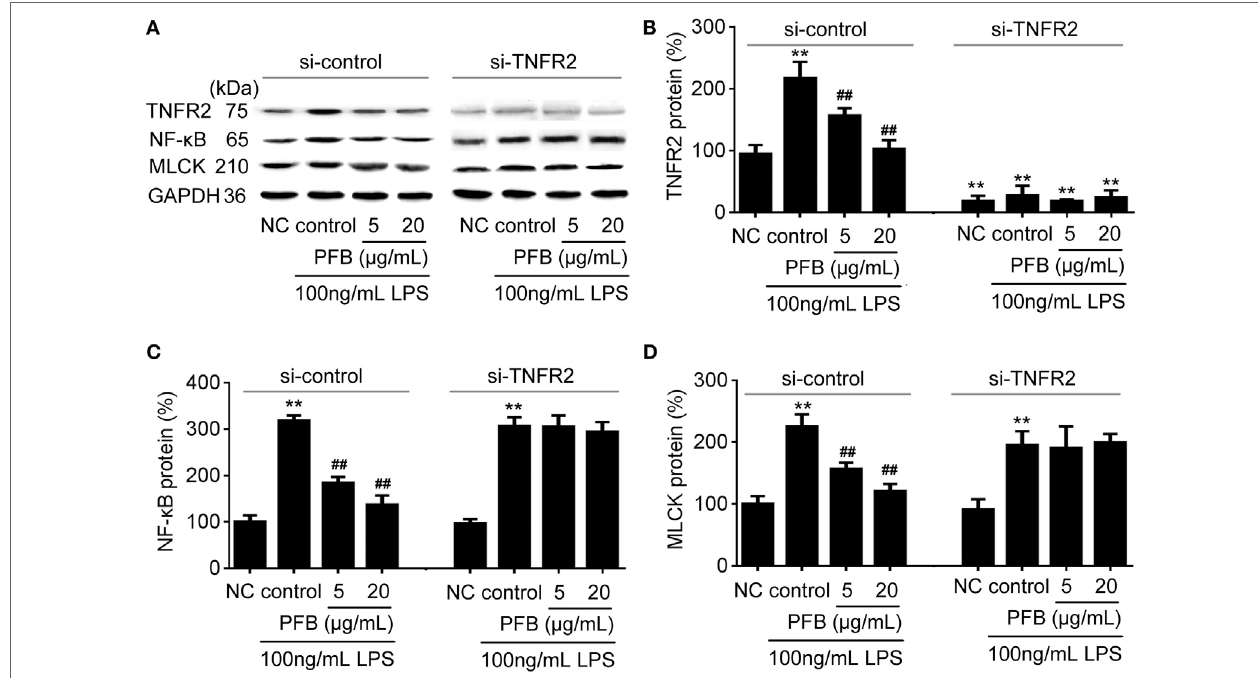
FigUre 6 | Downregulation of TNFR2 in purified fruit bromelain (PFB)-induced inhibition of inflammation and epithelial barrier dysfunction. Effects of PFB on expression of TNFR2, NF- κ B and MLCK in the presence of siRNA targeting TNFR2. (a) Representative Western blotting image for effects of PFB on expression of TNFR2, NF- κ B and MLCK; statistical analysis of PFB on the expression of TNFR2 (B) , NF- κ B (c) , and MLCK (D) . Representative Western blotting image for effects of PFB on NF- κ B and MLCK. Data are expressed as the mean ± SD. Values are given relative to normal control (NC) in si-control (100%) and other values are given relative to the NC group: ** P < 0.01 compared with NC; ## P < 0.01 compared with corresponding LPS